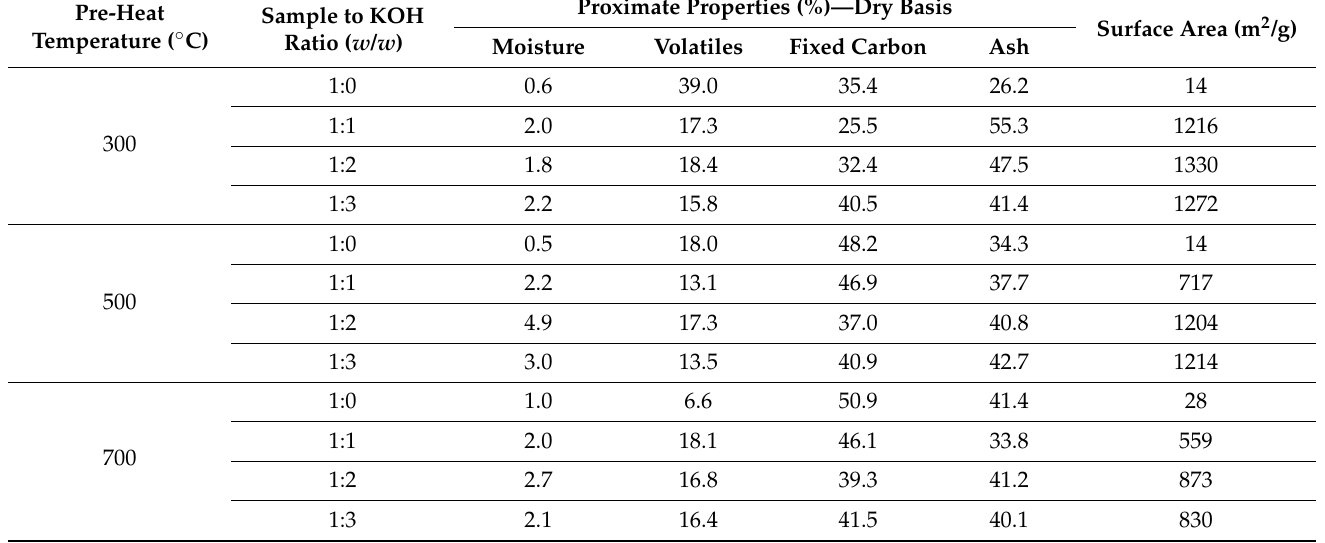
Table 7. The proximate properties of CM-DTH and